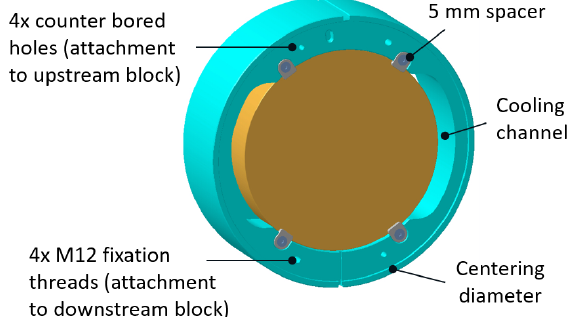
FIG. 16. Description of one target block support, part of the target inner tank. Each support integrates different elements that permit the assembly with the previous and following supports, as well as the water circulation around the target blocks.